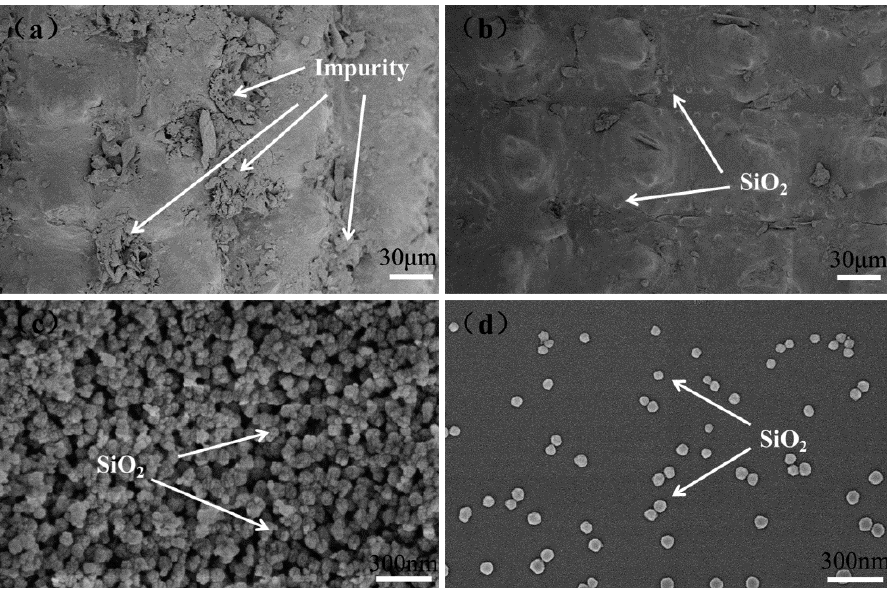
Figure 2. Surface morphology of rice husk and RHNS: ( a ) original rice husk; ( b ) rice husk treated with 5% HCl; ( c ) aggregated RHNS and ( d ) dispersed RHNS.